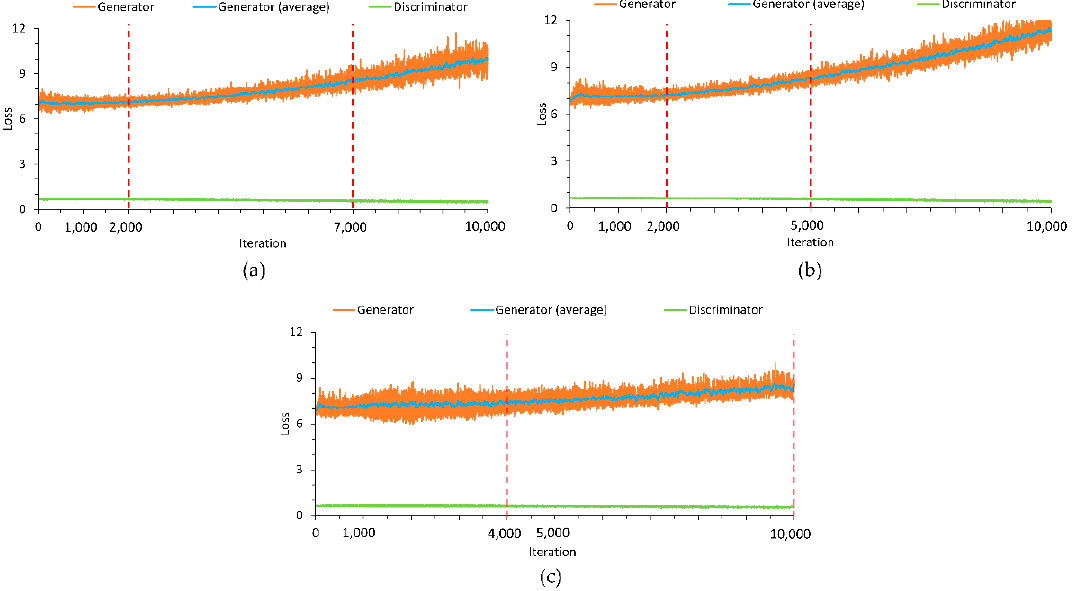
Figure 13. Generator and discriminator loss values recorded during the training process for ( a ) Class 1, ( b ) Class 2, and ( c ) Class 3 events.